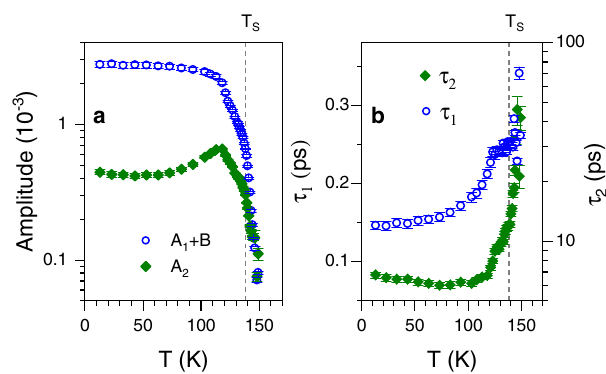
Fig. 4 Extracted fi t parameters of the overdamped components. Temperature dependence of a amplitudes and b relaxation times, τ 1 and τ 2 , obtained by fi tting re fl ectivity transients using Eq. (1). The triclinic phase transition temperature, T s , is denoted by the black vertical dashed line. The error bars are the standard deviation of the least-squared